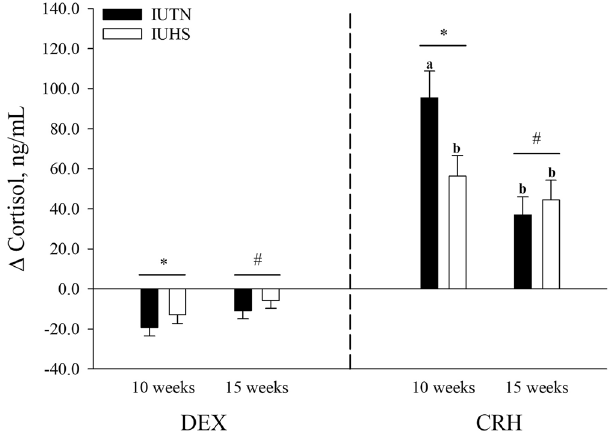
Figure 1. Effects of in utero heat stress (IUHS; n = 12 pigs per age category) or in utero thermoneutral (IUTN; n = 12 pigs per age category) conditions on the postnatal ∆ cortisol response of pigs following a dexamethasone (DEX) suppression test and a corticotrophin releasing hormone (CRH) challenge at 10 weeks and 15 weeks of age. Letters (a, b) indicate in utero treatment by age differences ( P = 0.02). Symbols (*, #) indicate overall age statistical trends (0.05 < P ≤ 0.01). Data are presented as LSmeans ±